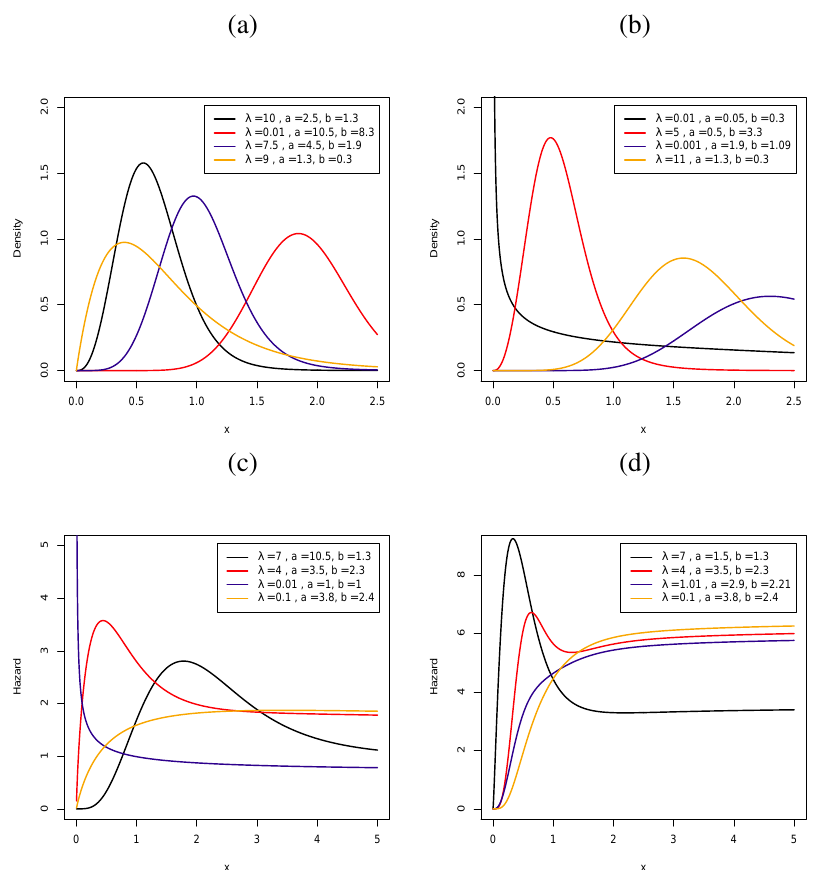
Fig. 2. Plots of the density and hrf of the Kw-GaP distribution for some parameter values. (a) For α = 7 and β = 3 . 2. (b) For α = 0 . 5 and β = 0 . 7. (c) For α = 0 . 5 and β = 0 . 7. (d) For α = 1 . 5 and β = 2 .